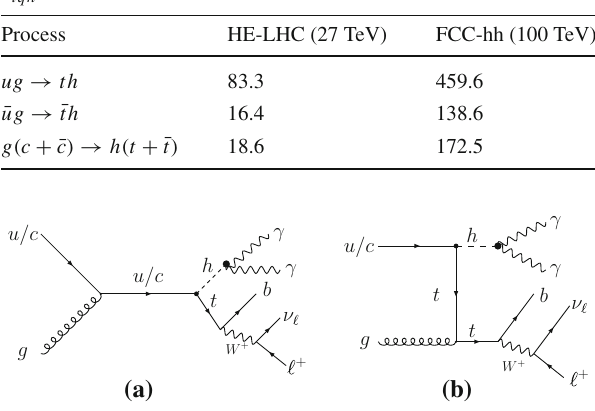
Fig. 2 The Feynman diagram for the pp → th process including